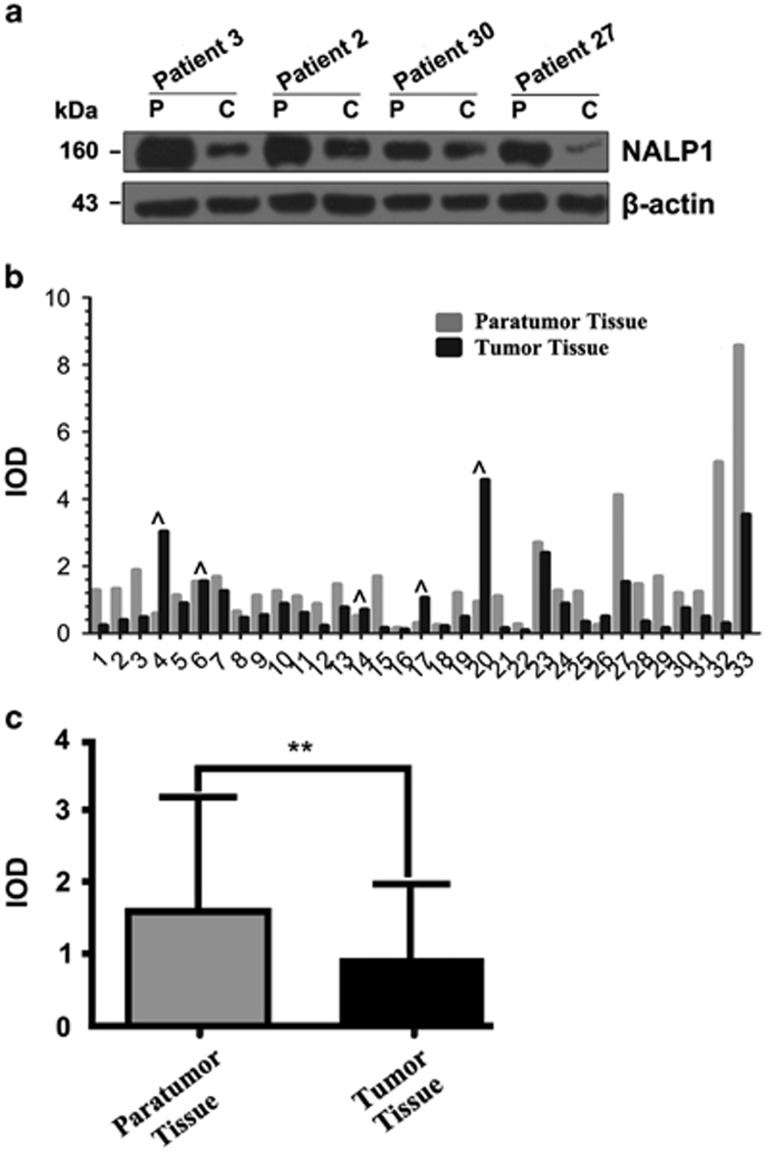
Western blot analysis of NALP1 protein expression in 33 human colorectal normal and cancer tissues. (a) The total soluble protein lysates (25 μg) were separated by SDS-PAGE and analyzed for protein expression. The sample information is described in Table 3. For example, ‘N' and ‘C' under the heading ‘Patient 3' are represented as CL3N and CL3T in Supplementary Table 2, respectively. β-Actin protein expression served as a loading control. (b) The human colorectal cancer tissue western blot analysis was used to determine expression levels of NALP1 protein. For the human tissue array, tissues were selected from 33 matched pairs of normal and cancer tissues. The y axis represents the IOD value of NALP1 protein. Data were obtained using the Gel-Pro32 analyzer software with the values normalized to β-actin levels. The bar with the single sign (^) indicates that the expression value of NALP1 protein in cancer tissue is higher than normal tissue. (c) The expression levels of NALP1 protein in human colorectal normal and cancer tissue, respectively. The western analysis was used to determine the expression levels of NALP1 protein. The y axis represents the integrated optical density (IOD) value of NALP1 protein expression. Data were obtained using the Gel-Pro32 analyzer software with the values normalized to β-actin levels. The difference in the expression level of NALP1 protein in colorectal normal versus cancer tissue was highly statistically significant as determined by Wilcoxon signed-rank nonparametric test; the P-values are represented by asterisks (**P<0.01)